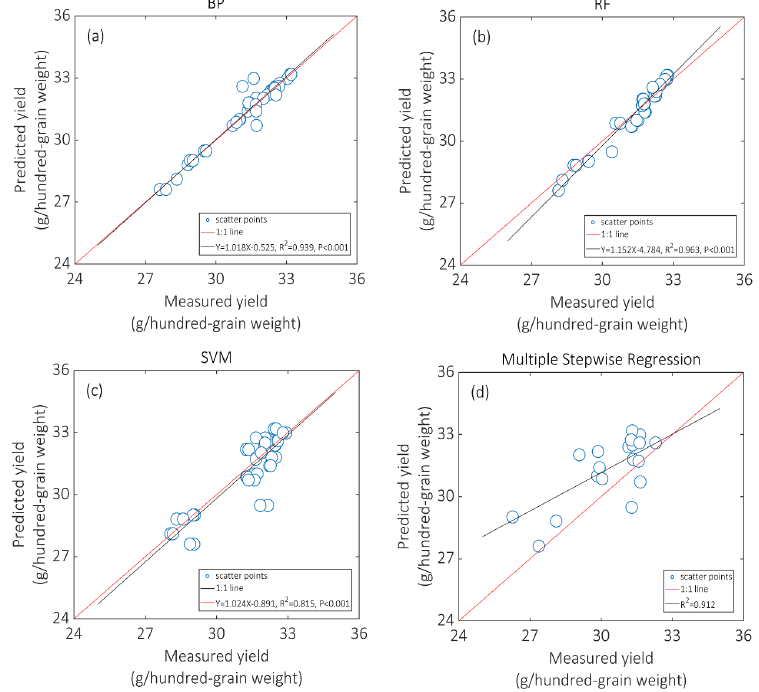
Figure 6. The comparison of measured and predicted maize grain yields using three machine learning methods and the stepwise regression model (SRM). Note: ( a – d ) represent the results using BP, RF, SVM and SRM, respectively.